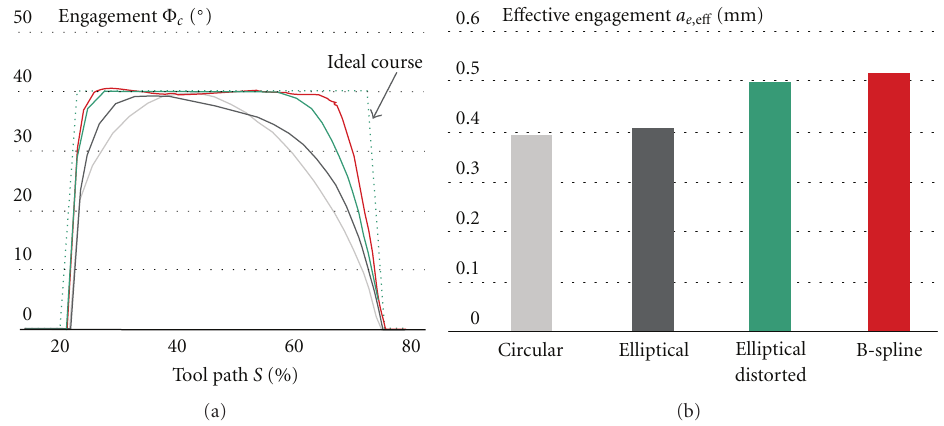
Figure 5: Optimized tool path geometries (a) and their influence on the e ff ective tool engagements (b).